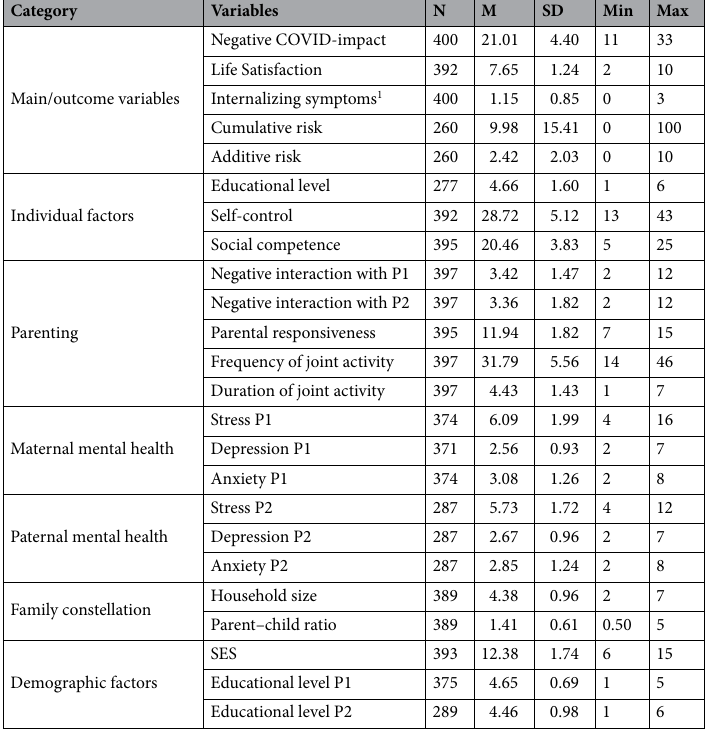
Table 1. Descriptives (sample size, mean and standard deviation) for all variables. P1 = mothers & P2 = fathers. For family composition and migration background, see the “Measures”